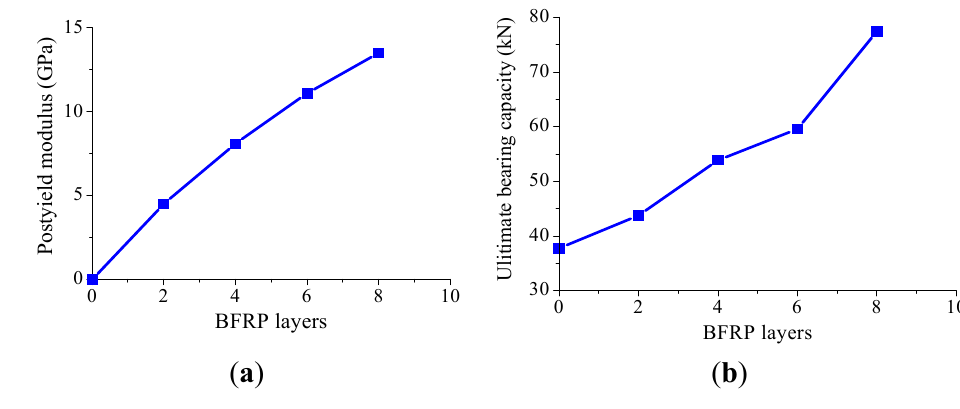
Figure 9. The effect of the number of BFRP layers on ( a ) the postyield modulus and ( b ) the ultimate bearing capacity.